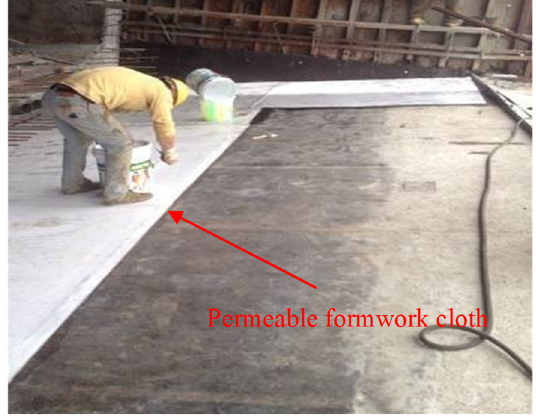
Figure 4. Spraying conservation agent curing method.